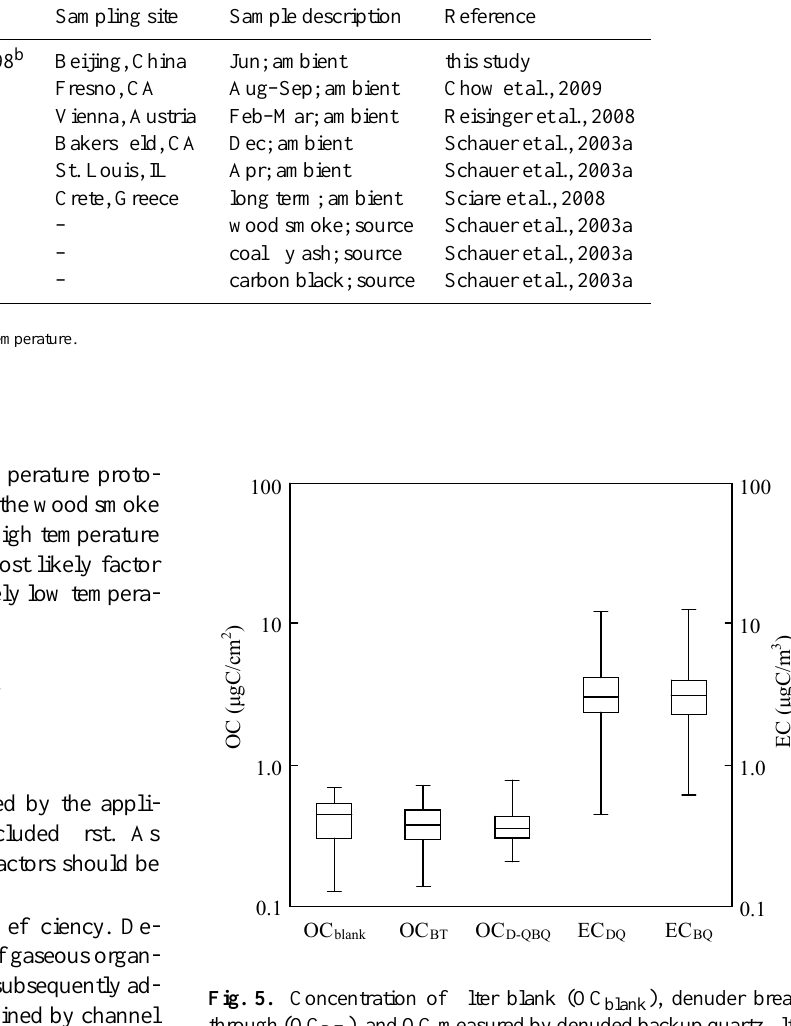
Table 3. Ratios of EC value determined by different temperature protocols.